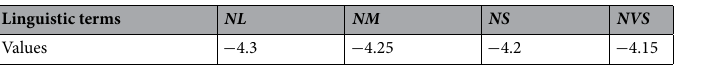
Table 3. The reference values and points of the X-axis gyroscope light intensity voltage.